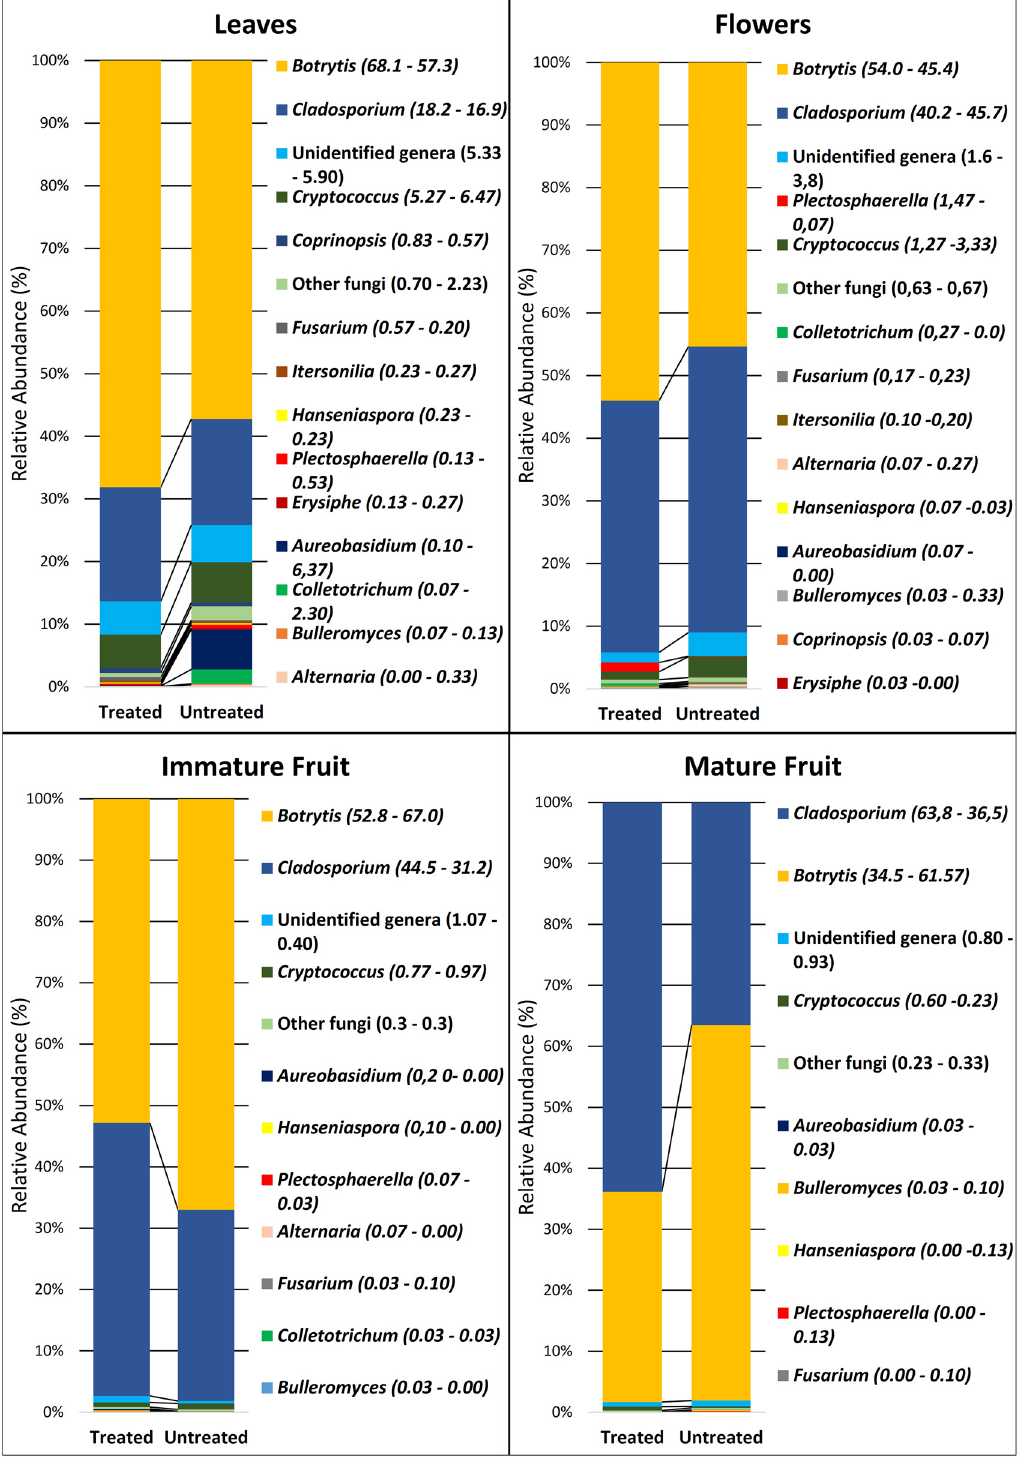
Fig 6. Relative abundance of the fungal genera in treated and untreated strawberry flowers, leaves and immature and mature fruit. The exact relative abundance (percentage) of each genus in treated (left number) and untreated (right number) samples is reported between